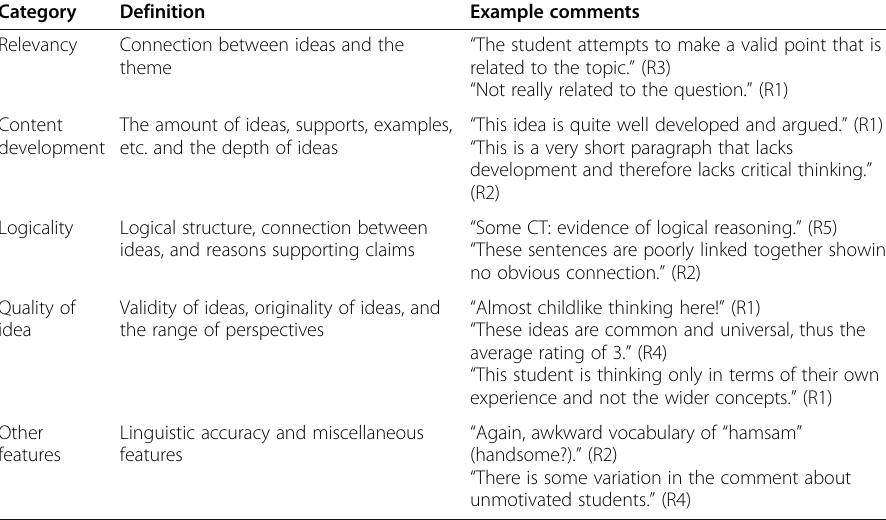
Table 4 Categories of influential features of argumentative